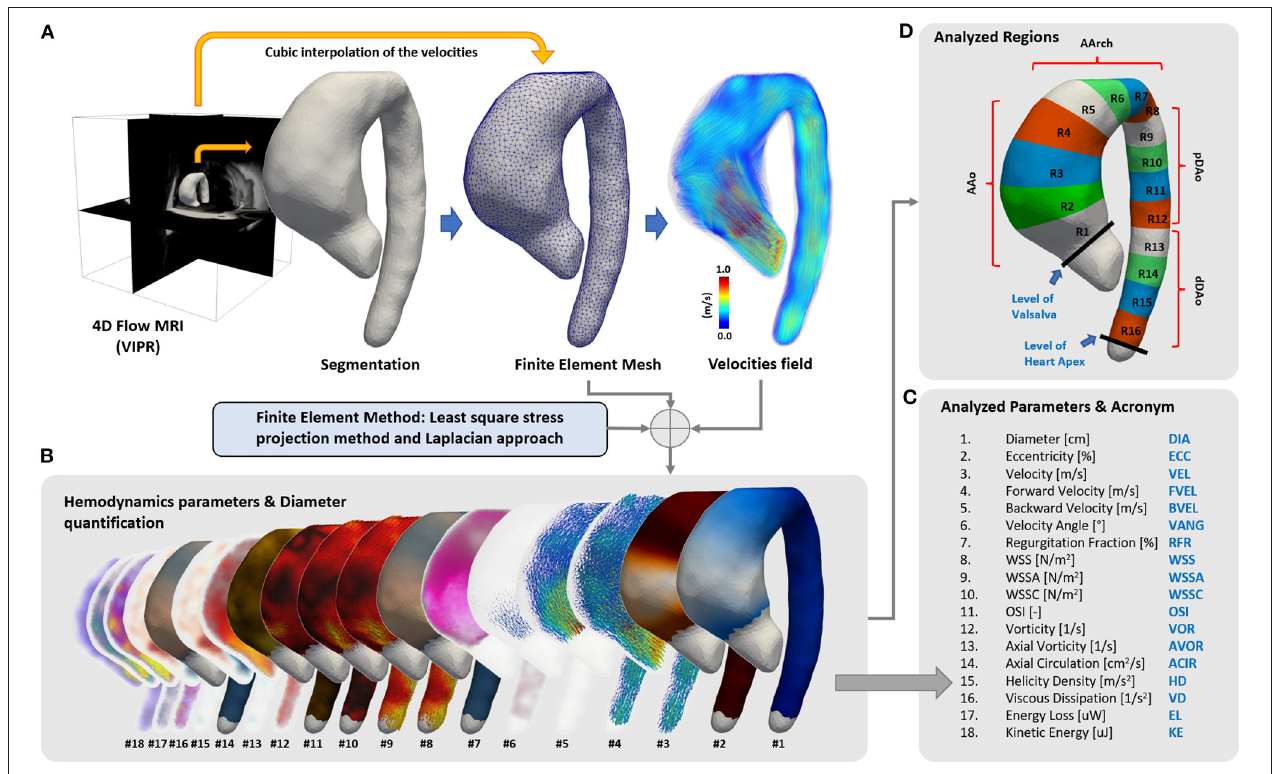
FIGURE 1 | Summary of the quantification process. (A) From the 4D-flow CMR acquisition, a semiautomatic segmentation of the aorta was generated and transformed into a tetrahedral mesh. Then, 4D-flow CMR velocity values were interpolated to each node of the mesh, and (B,C) 3D maps of 17 hemodynamics parameters and the diameter were calculated using finite elements. (D) A total of 16 different regions of the aorta were created to compare the data between volunteers and